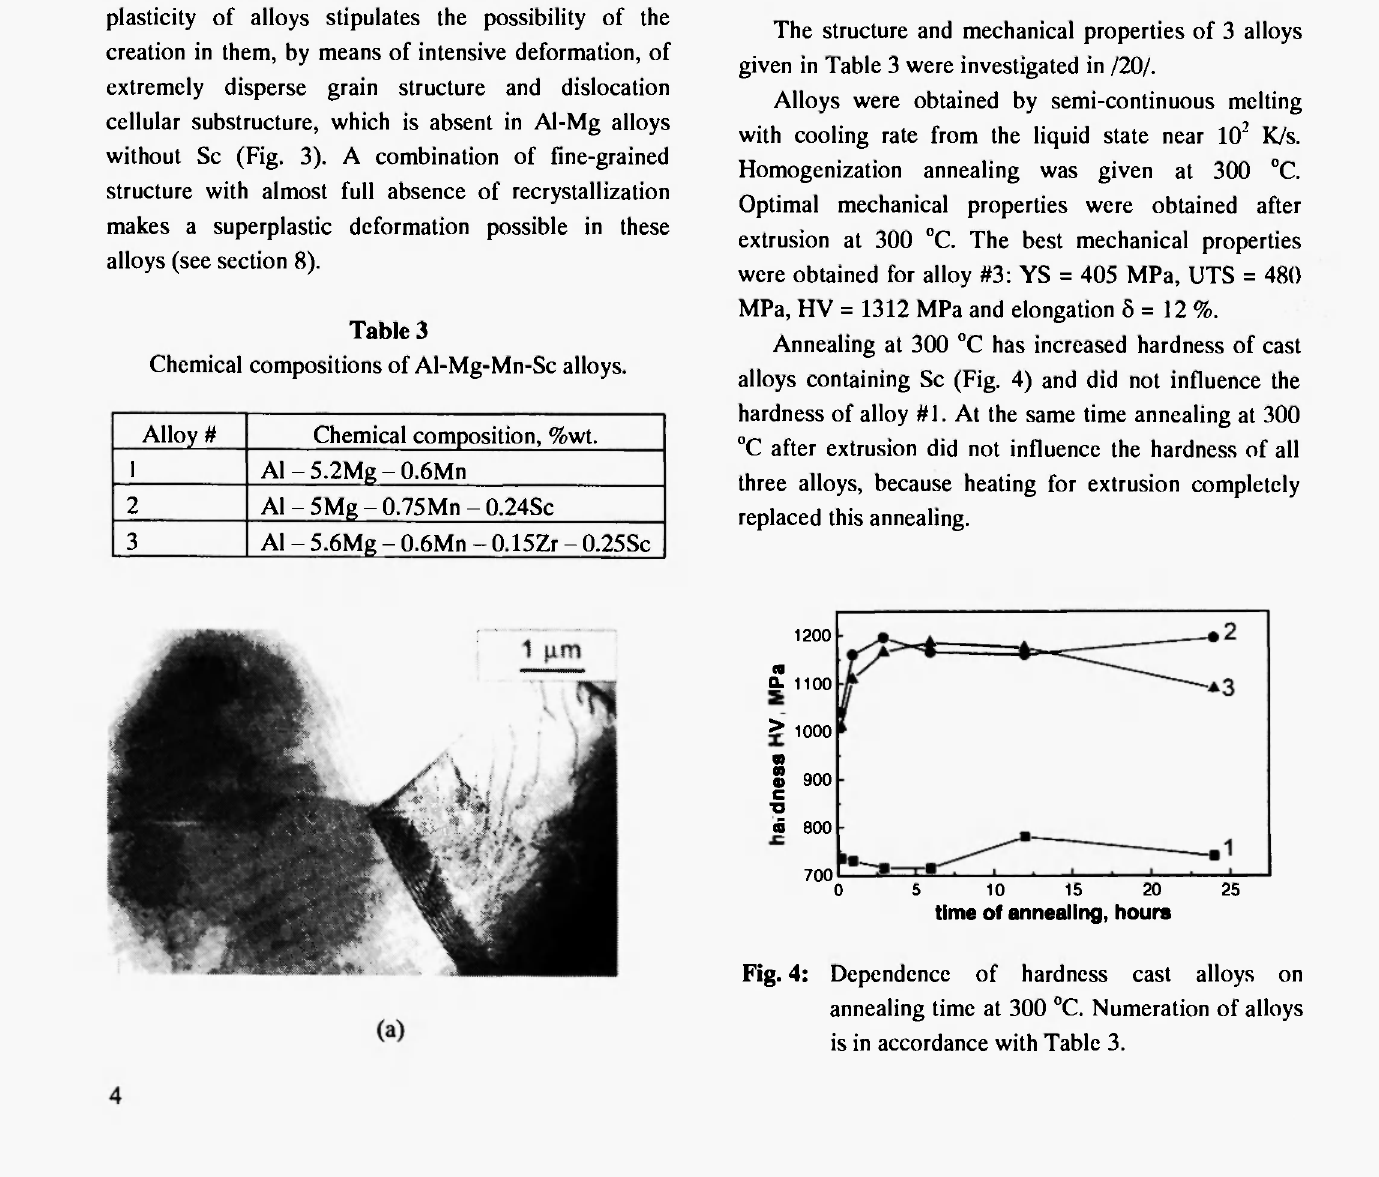
Fig. 3: Dislocation structure in Al-4.9%wt.Mg (a) and dislocation cellular substructure in Al- 5.2%wt.Mg-0.3%wt.Sc (b).